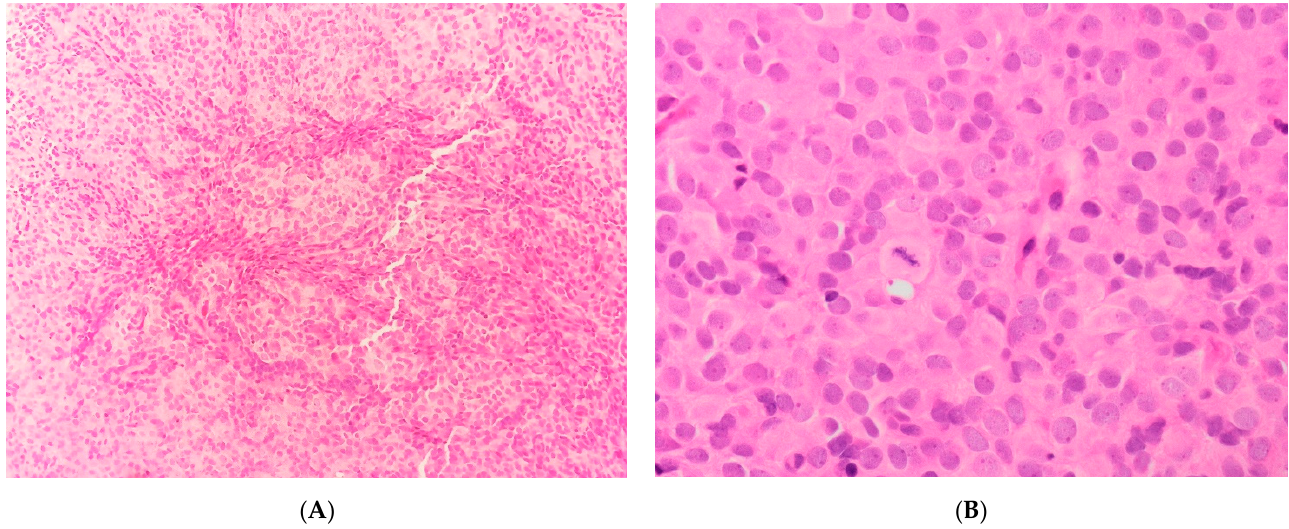
Figure 6. ( A ) Vague nested architecture in YWHAE-NUTM2 sarcoma. ( B ) Cellular morphological details in YWHAE-NUTM2 sarcoma.